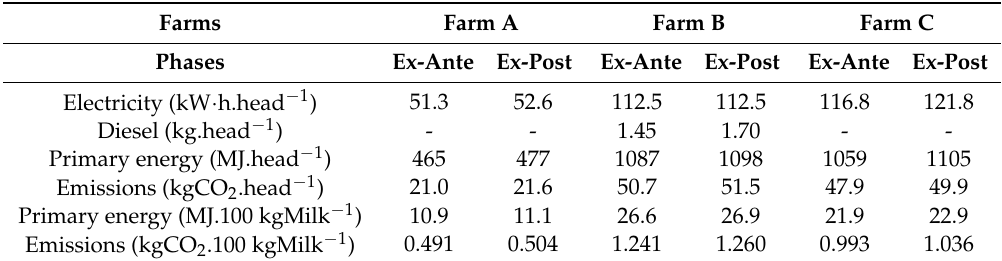
Table 2. Energy and carbon dioxide emissions summary, in the ex-ante and ex-post phase, reported for each dairy farm and the related energy and carbon